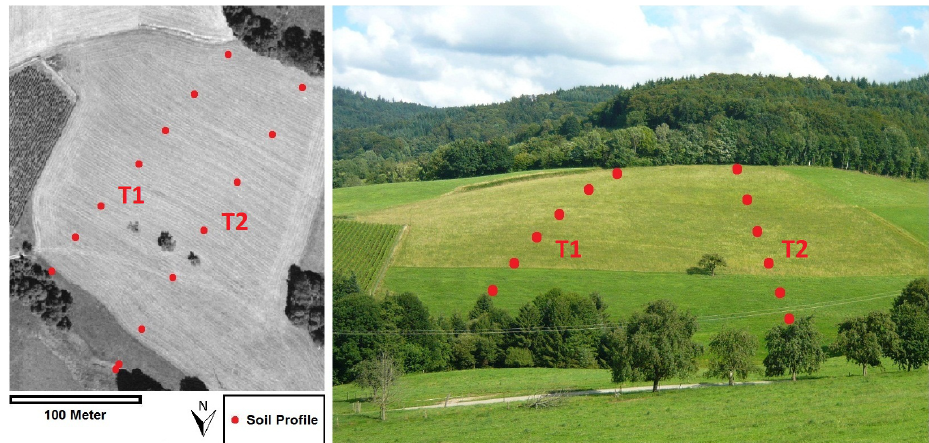
Fig. 1. Transect T1 and transect T2 along the study hillslope from above (left) and from below